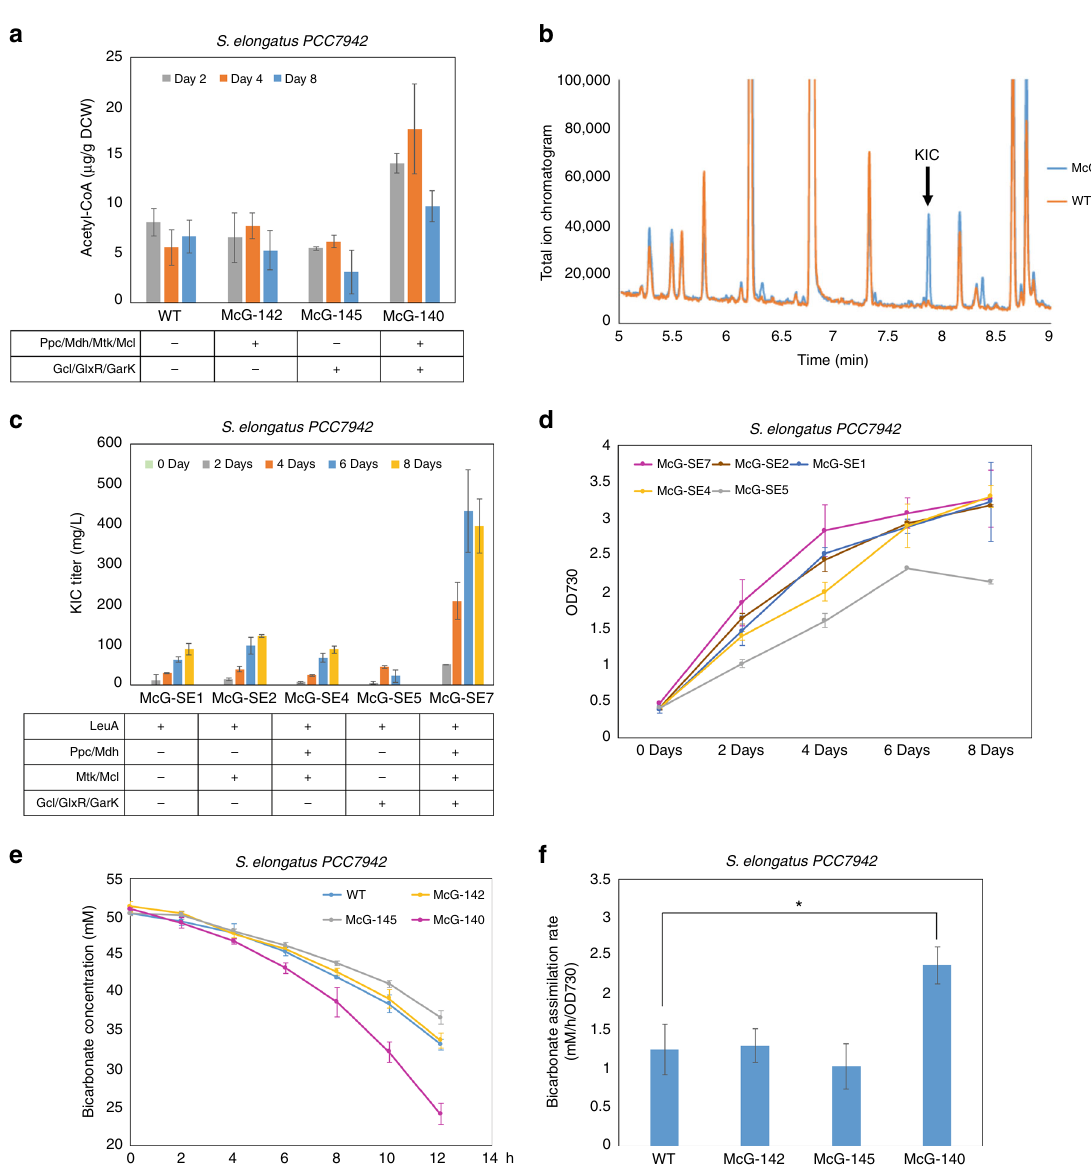
Fig. 4 MCG pathway increased the intracellular acetyl-CoA pool and enhanced carbon fi xation in S. elongatus . a Expression of the complete pathway genes in the strain McG-140 increased the intracellular acetyl-CoA level compared to wild type and the controls expressing partial pathway genes. Error bars are s.d., n = 3. b GC-MS identi fi cation of ketoisocaproate (KIC) production in the McG-140 culture. c The strain McG-SE7 signi fi cantly increased the KIC production compared to the controls with expression of the partial pathway genes. The KIC titer in the McG-SE7 achieved the highest amount of 433 mg/L. Error bars are s.d., n = 3. d The strain McG-SE7 promoted cell growth to saturation faster than all the controls. Strain designations are de fi ned as in c . Error bars are s.d., n = 3. e , f The McG-140 strain assimilated more bicarbonate than wild type and the controls expressing the partial pathway ( e ), and increased the bicarbonate assimilation rate ( f ) as well. The bicarbonate assimilation rate ( f ) was shown between the eighth to tenth hour of e , which displayed the most obvious differences. Strain designations are de fi ned as in a . Error bars are s.d., n = 3. * P < 0.05 ( t -test, two mM bicarbonate under oxygen-limited condition. Glucose theoretical value of 3 in E . coli (Supplementary Fig. 2b ) . Ppc( C . g ) consumption and C2 compounds production, including acetate was used since it displayed much higher carboxylase activity with and ethanol, were measured after 24 h. The results showed that or without acetyl-CoA compared to the one from E . coli expression of mtk ( M . c )/ mcl ( M . e ) alone was only able to increase (Supplementary Fig. 6b and Supplementary Table 6). the titer of C2 compounds slightly compared to the control To determine accurately the carbon fi xation ability of the containing empty plasmid (Fig. 3b). Overexpression of gcl ( E . c ), pathway, we grew the strain in LB medium supplemented with hyi ( E.c ), garK ( E . c ), and mdh ( E . c ) further increased the C2 uniformly 13C-labeled glucose (M + 6) and 13C-bicarbonate (M + 1), and measured the production of double labeled C2 compound production. Additional expression of ppc from Corynebacterium glutamicum improved the titer of C2 com- compounds (M + 2). The M + 2 form of the C2 produced and pounds to 70.1 mM. After subtracting the C2 (12.2 mM acetate) the M + 6 form of glucose consumed could evaluate the effect of produced in LB medium without glucose, the fi nal corrected C2/ the MCG pathway. If the MCG pathway is functioning, the (M + C6 molar yield achieved 2.9 (Fig. 3b), approaching the maximum 2) C2/(M + 6) C6 molar yield should exceed 2, which is the